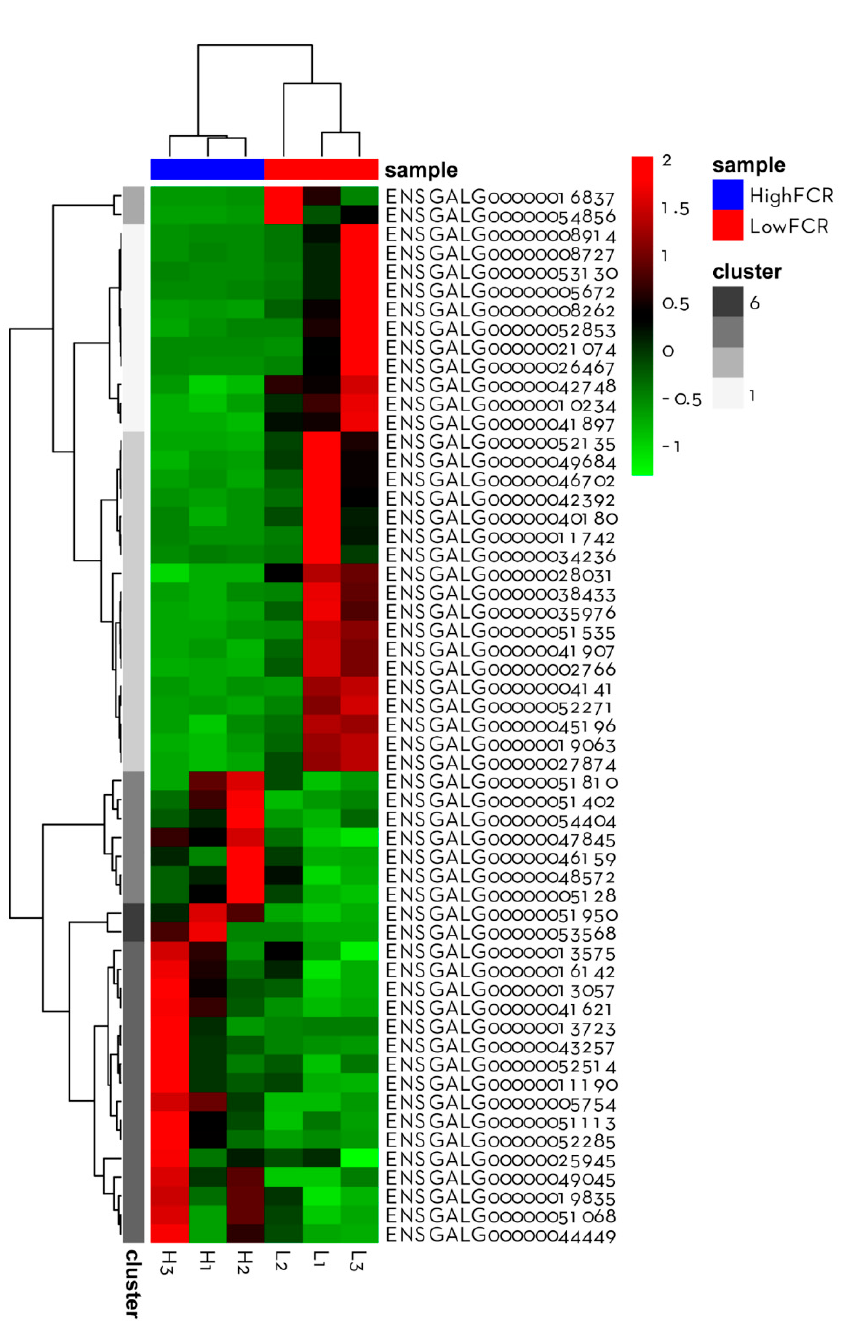
Figure 3. Volcano plot of the 24,356 transcripts quantified in the jejunum from KR chickens with differences in FCR. The horizontal lines indicate the significant thresholds of DEGs at p -value < 0.01. The vertical line corresponds to the threshold of |log 2 FC| > 1. Red dots represent the significant DEGs at p -value < 0.01 and |log 2 FC| > 1 .